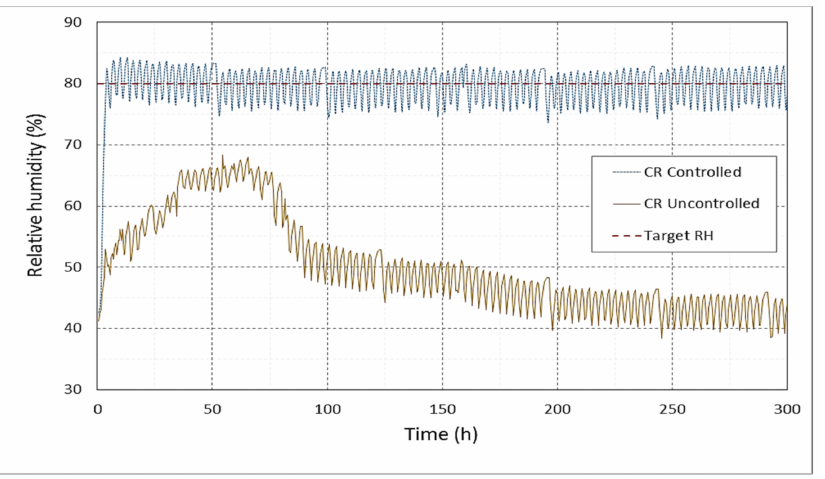
Figure 10. Relative humidity in the centerline of the controlled cold storage room (CR Controlled) and of the uncontrolled cold storage room (CR Uncontrolled) versus the target relative humidity of 80% (Target RH).